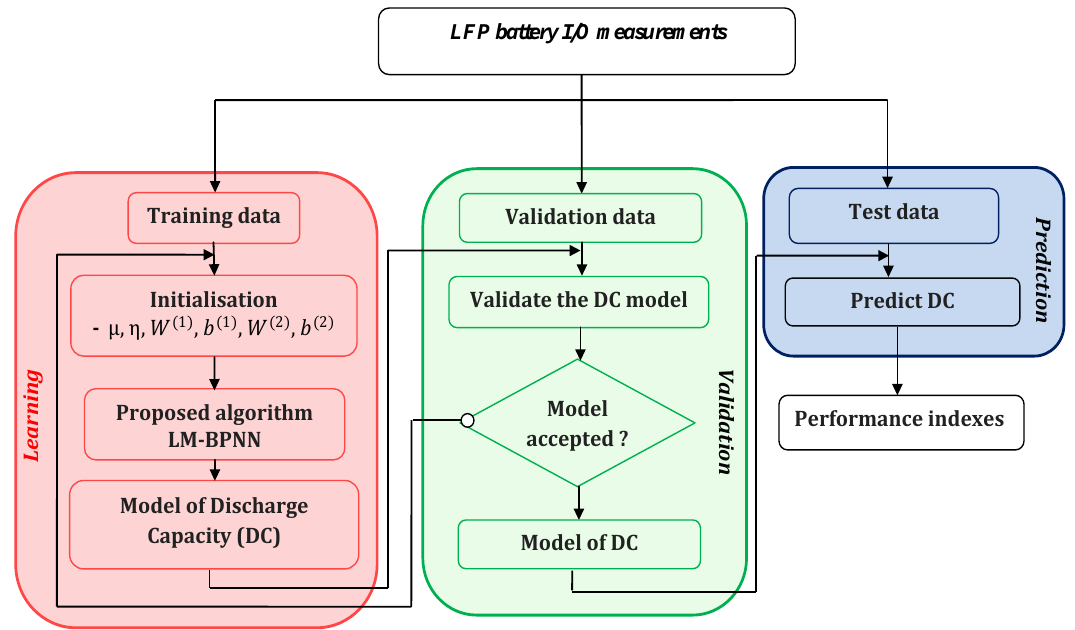
Figure 5. Flowchart of the proposed